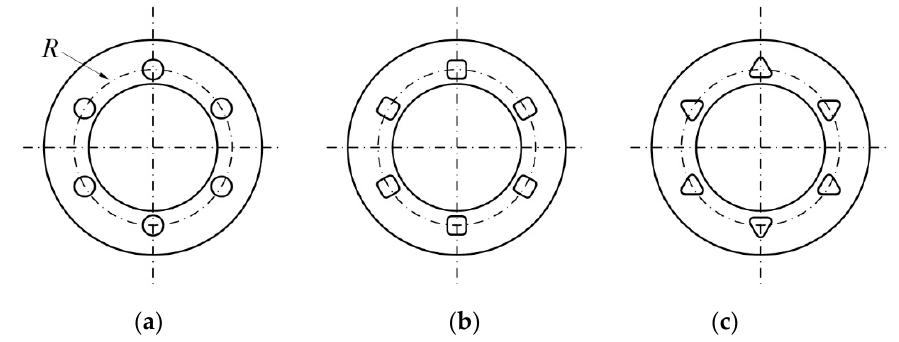
Figure 3. The nozzle structures. ( a ) Circular nozzle; ( b ) Square nozzle; ( c ) Triangle nozzle.